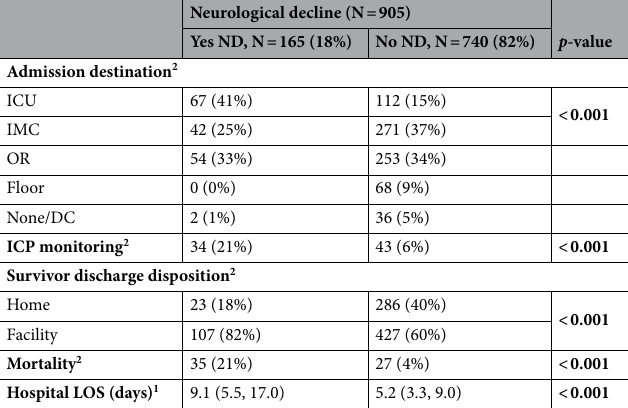
Table 2. Clinical characteristics and outcomes of hospitalization. Statistical significance and p-values were assessed for ordinal variables using Wilcoxon rank sum tests 1 and for categorical variables using Chi-squared tests 2 . ICP = intracranial pressure; LOS = length of stay; ICU = intensive care unit; IMC = intermediate care unit; OR = operating room; DC = discharged. Significant values are in bold.